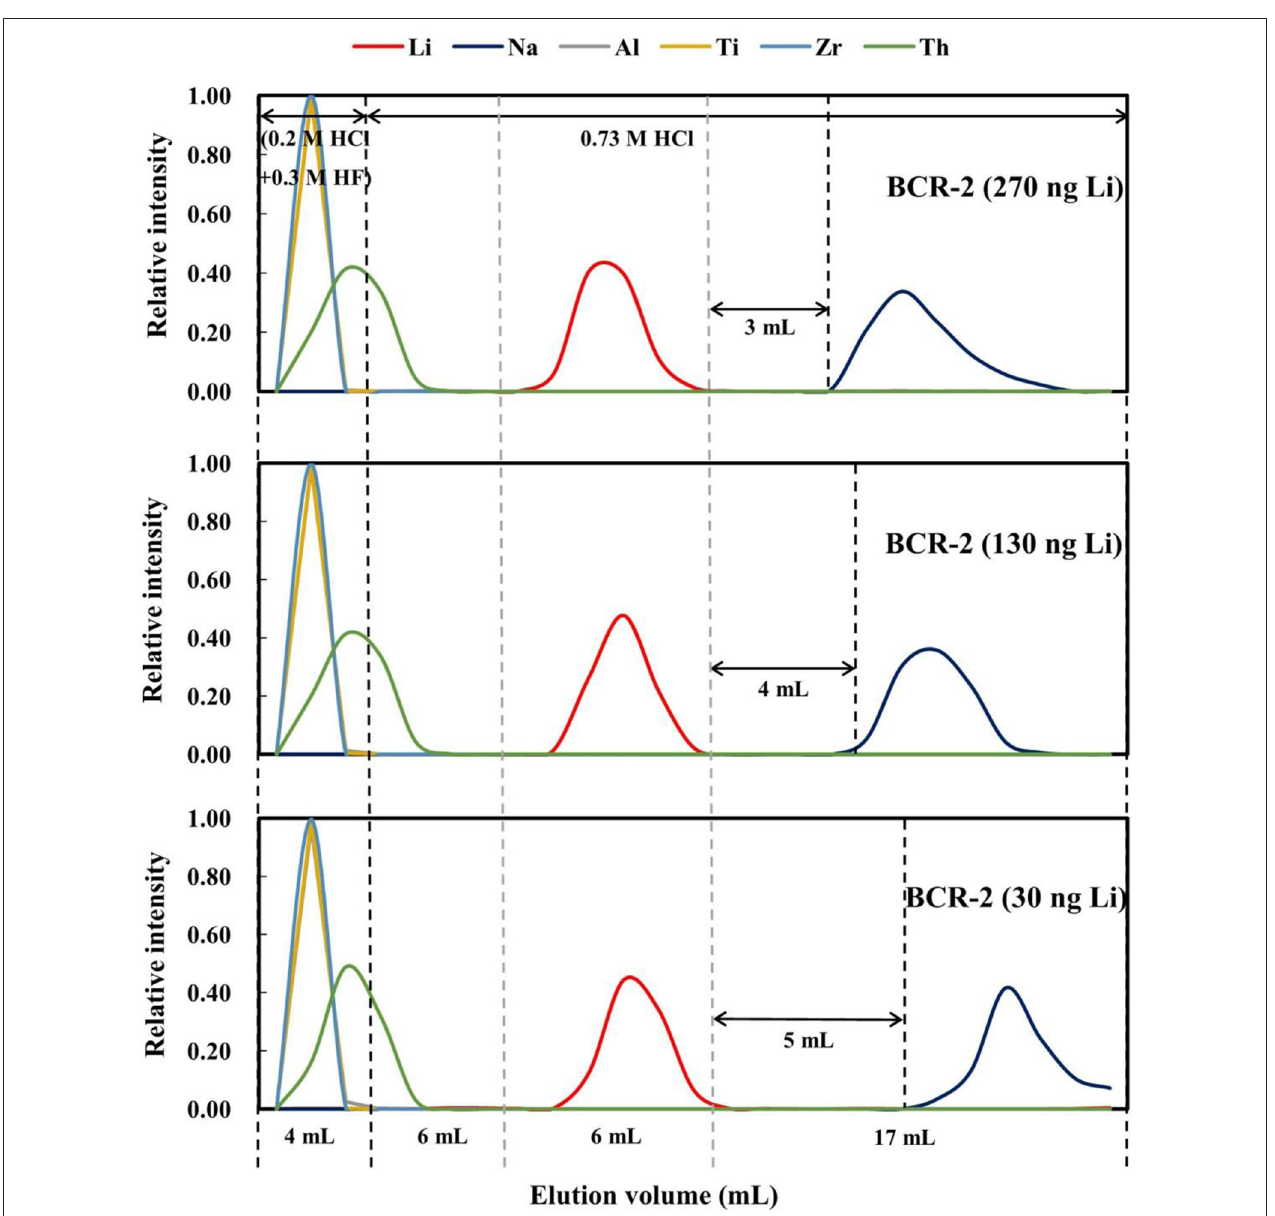
FIGURE 6 | Elution curves for BCR-2 with different Li loads (270, 130, and 30 ng Li) on AGMP-50